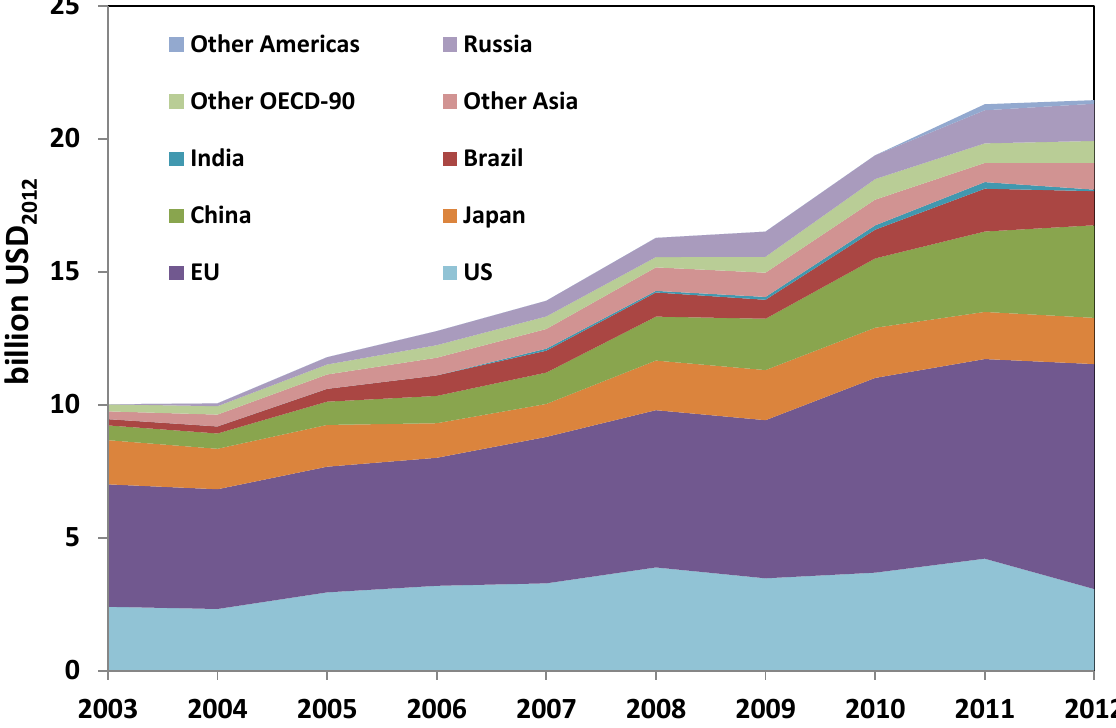
Figure 12. Private sector energy R&D spend over the period 2003–2012, by region [2]. (Includes only companies spending more than $76 m